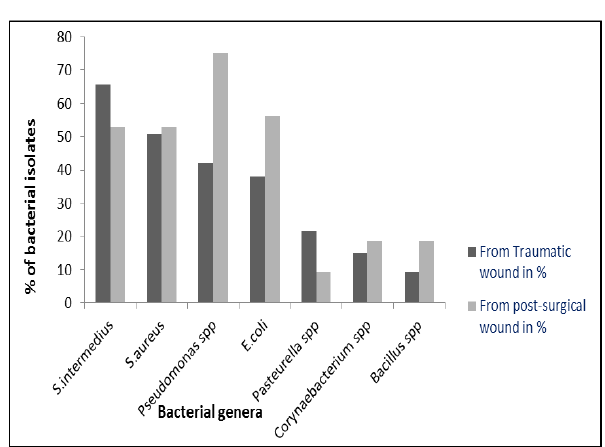
Figure-1: Graph showing percentage of bacterial genera isolated from traumatic and post-surgical wounds. Table-1: The prevalence of different bacteria species from canine infected wounds (n=172). Types of